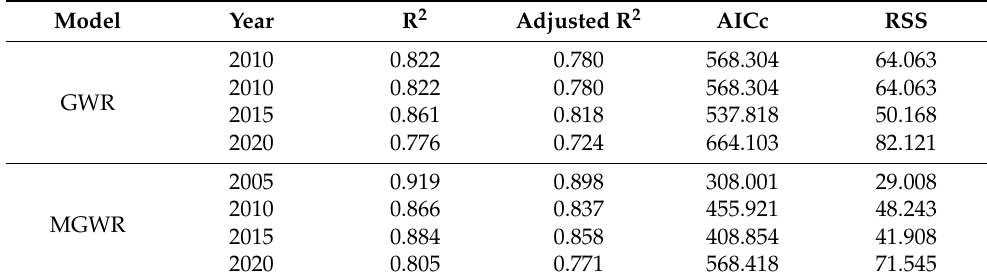
GWR: geographically weighted regression, MGWR: multiscale geo-weighted